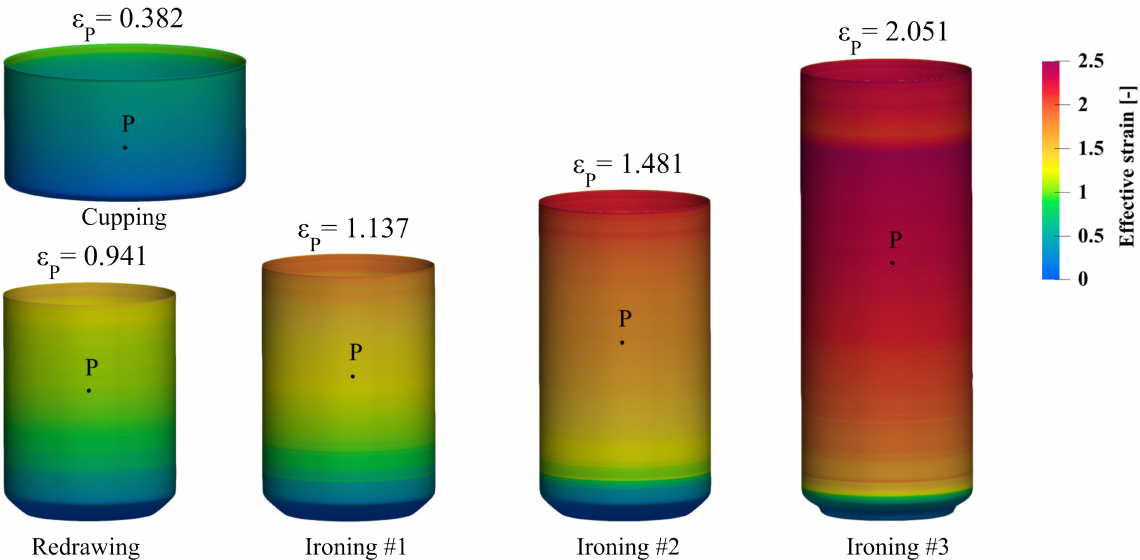
Figure 12. Distribution of the effective strain in the first five steps of the beverage can forming process with developed model (2) and parameters from Table